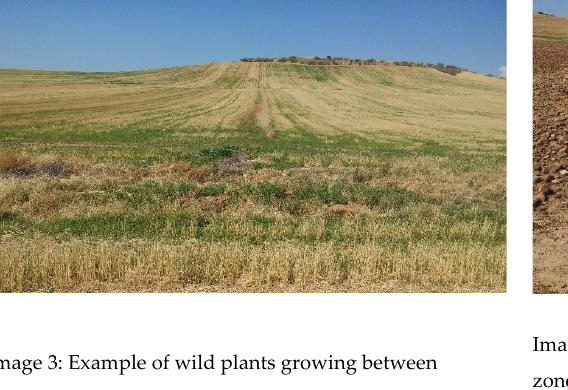
Image 3: Example of wild plants growing between remnants of cereal crops after harvesting Figure 14. Selection of field visit pictures. The sites pictured are marked in Figure 12 STM-2 and were taken from the circle pointing to each callout.